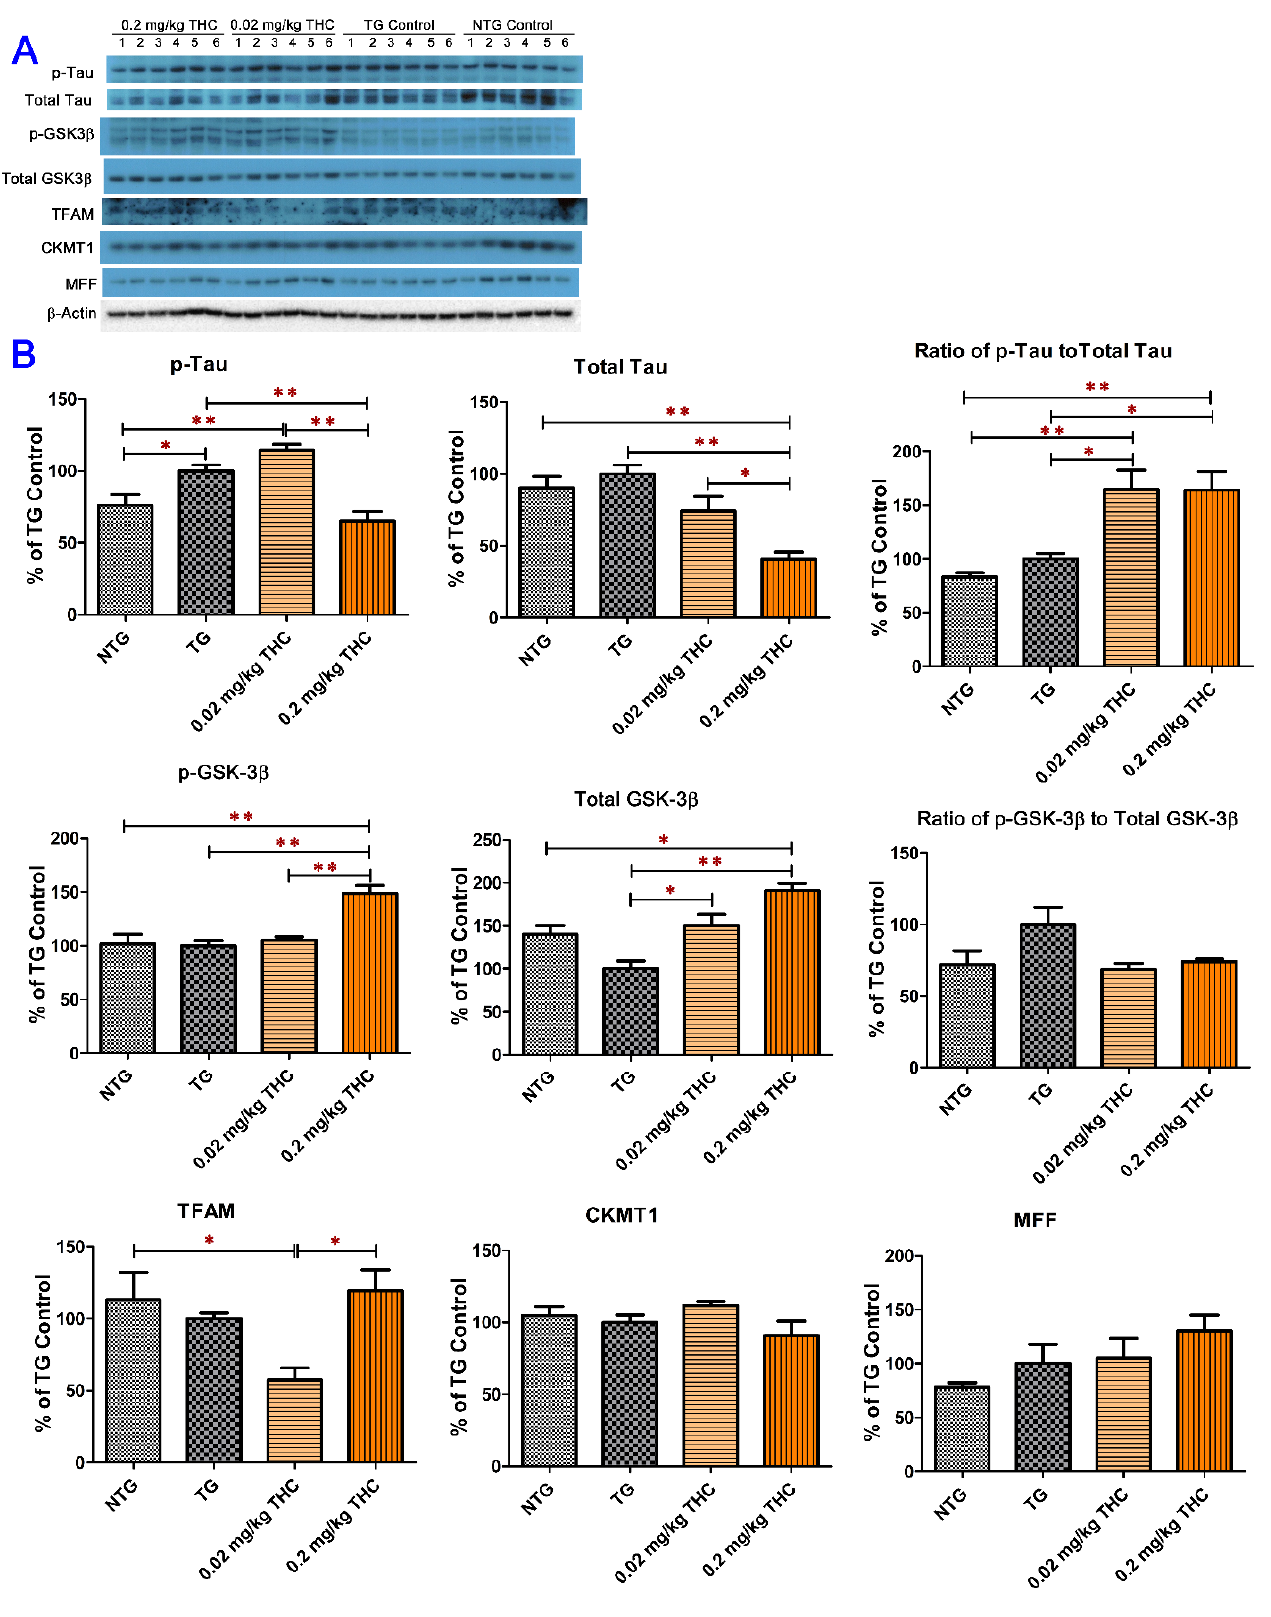
Figure 7. Evaluation of the effect of THC on the protein expression of phospho-tau, total tau, phospho-GSK-3 β , total GSK-3 β , TFAM, CKMT1, and MFF in brain homogenates using western blot anal- ysis. ( A ) Western blot images of the expression of total and phosphorylated Tau and GSK-3 β , TFAM, CKMT1, and MFF proteins in individual brain homogenate samples collected from the control NTG